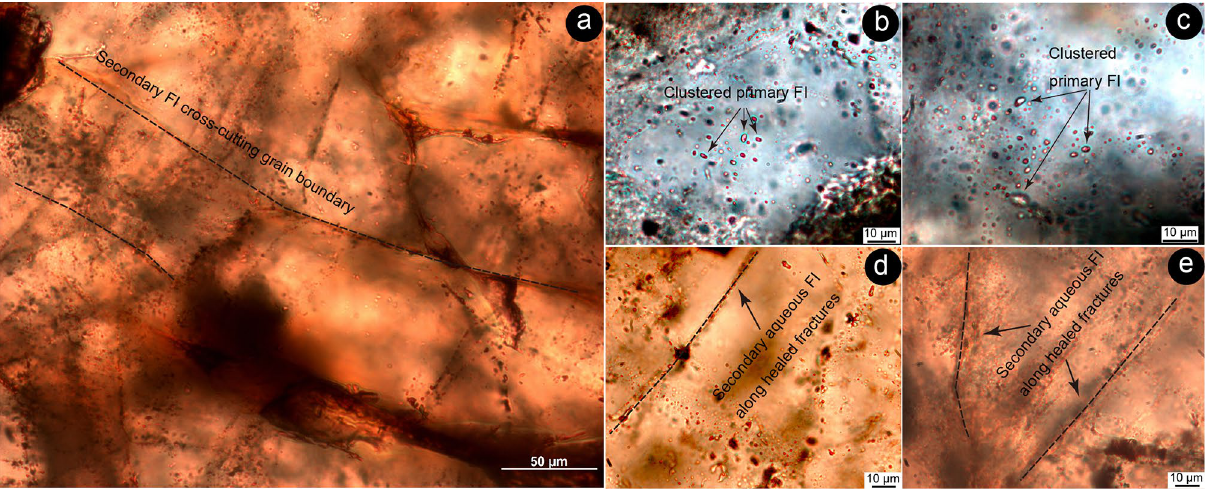
Figure 3. Microphotographs of fluid inclusions in sample LT19-1-2Qz from the Au-bearing quartz vein from Liaotun gold deposit. ( a ) primary and secondary fluid inclusions in vein quartz, and secondary fluid inclusions cross-cutting grain boundary; ( b , c ) isolated and clustered primary fluid inclusions in vein quartz; ( d , e ) secondary fluid inclusions in vein quartz along healed fractures.